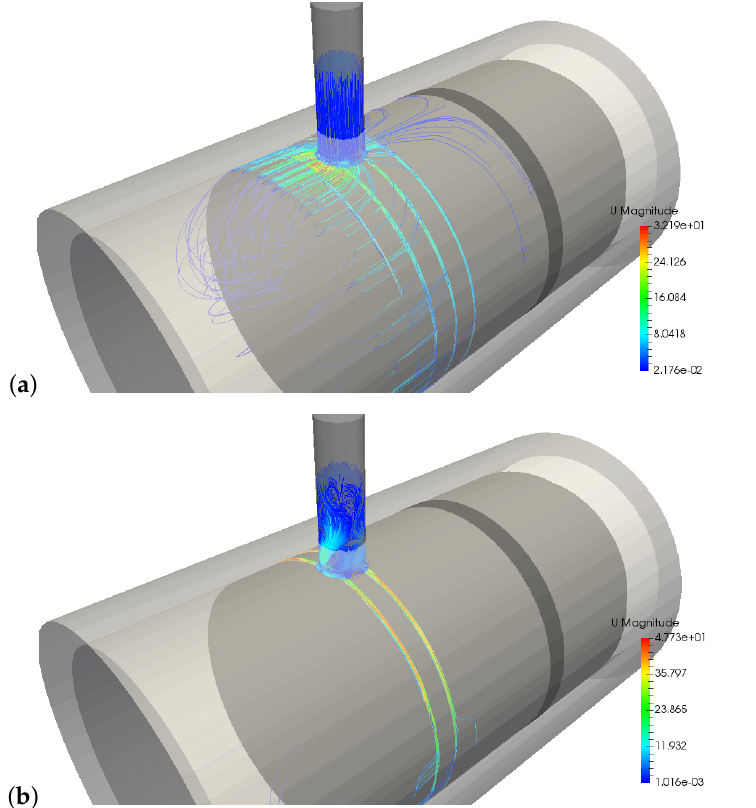
Figure 10. Streamlines for outlet flow for position R34 for centered piston ( a ) and attached piston ( b